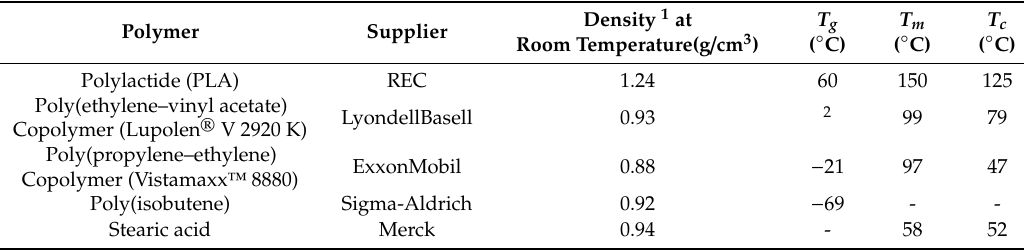
Table 2. Physical properties of polylactide (PLA) and the binder